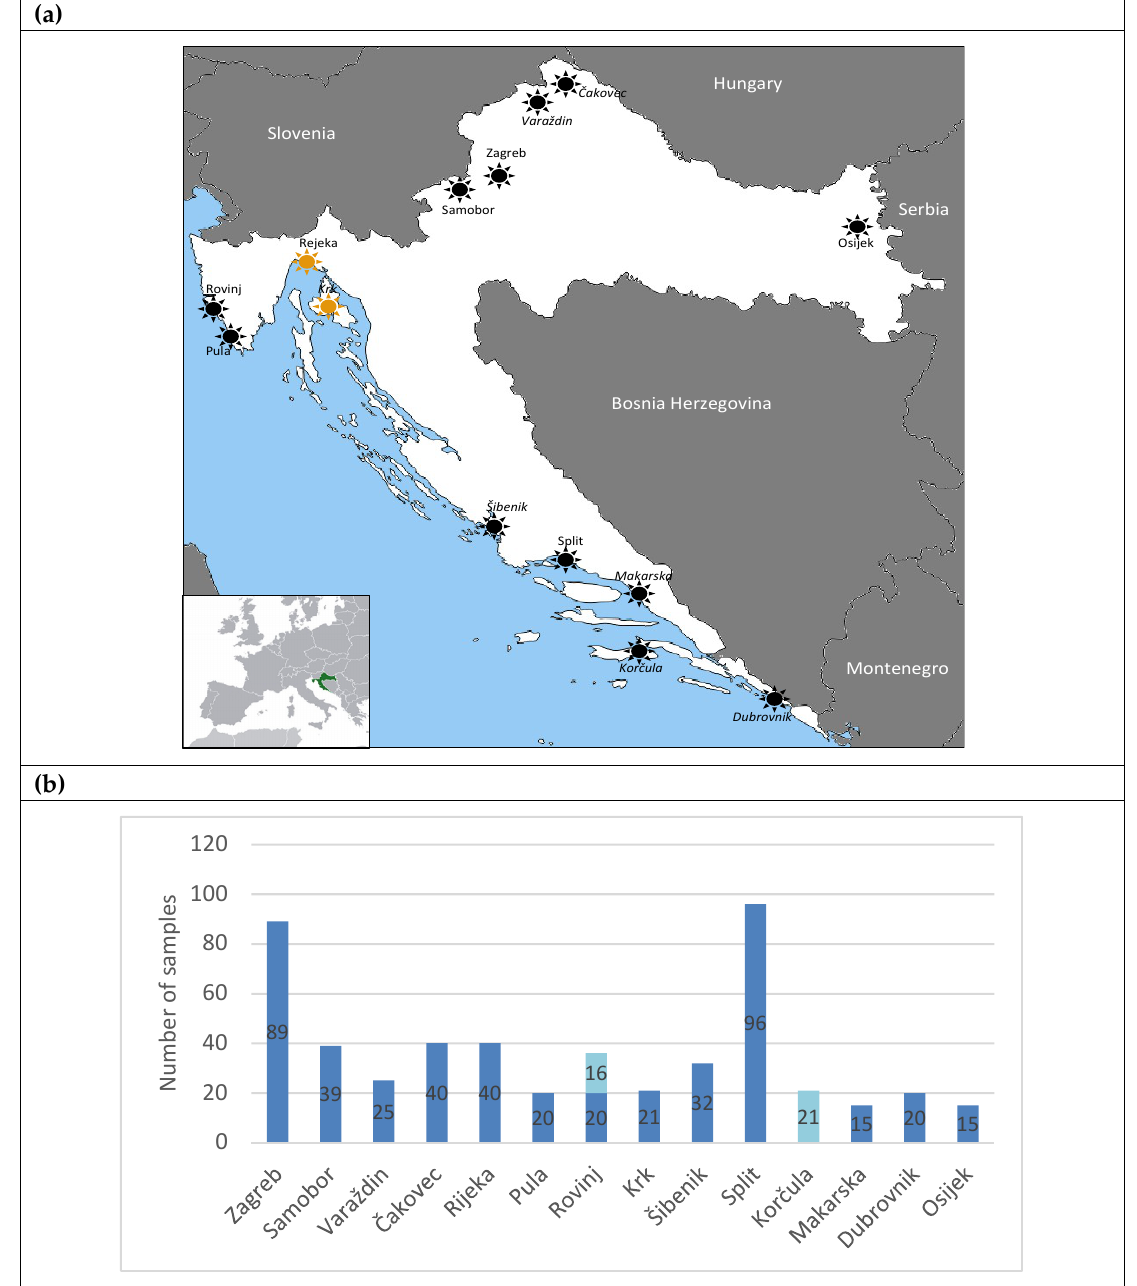
Figure 1. ( a ) The map represents the geographic distribution of the environmental samplings. Locations marked in yellow indicate the towns where positive samples were recovered. The inset shows the geographic position of Croatia in Europe. ( b ) The number and type of sample collected in each of the 14 sampling locations. Dark blue bars, samples from tree hollows; light blue bars, samples of bird excreta in the soil beneath the trees.